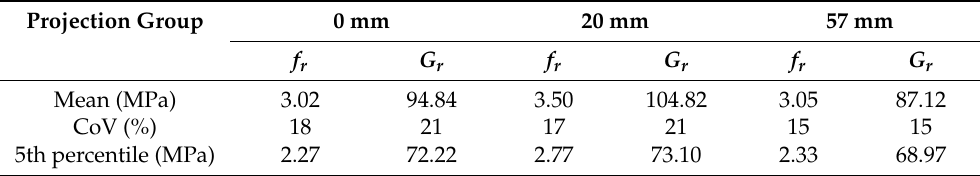
Table 9. Rolling shear properties with varying